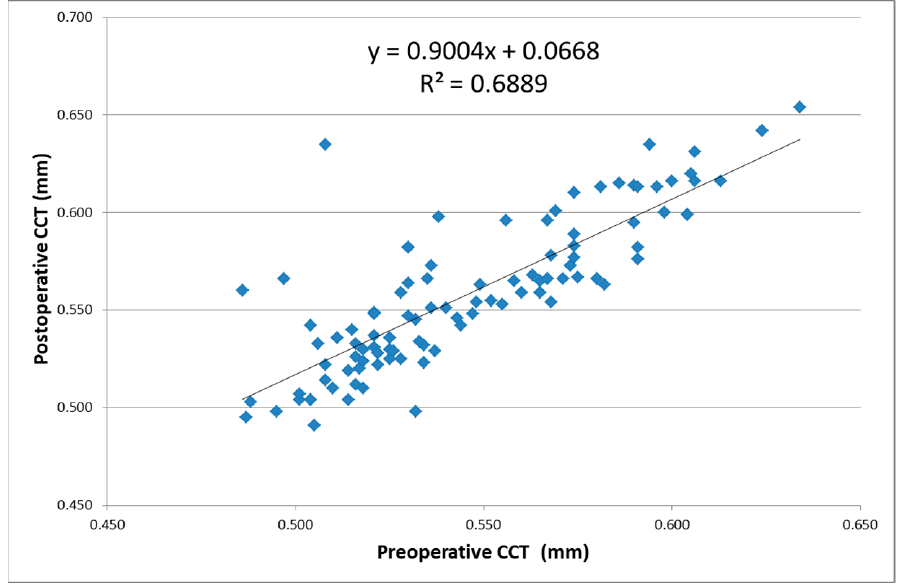
Figure 3. Correlation between the postoperative and preoperative central corneal thickness (CCT) values.